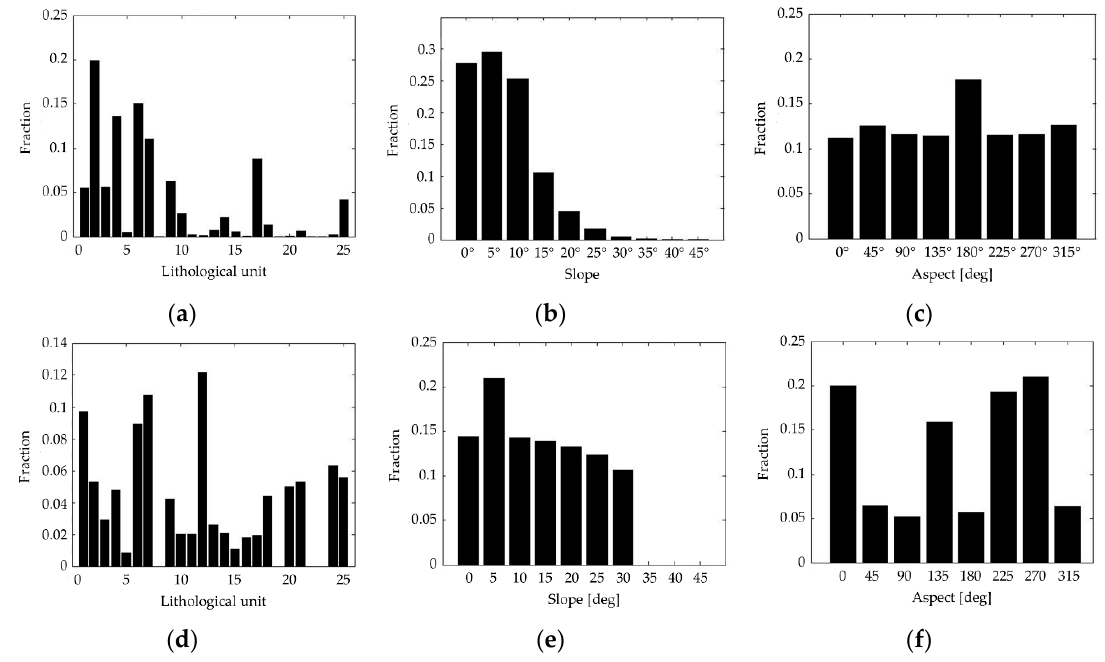
Figure 5. Normalized frequency distributions of LU units ( a ), slope ( b ) and aspect angles ( c ); normalized frequency distributions of PS (ERS 1992–1997) as a function of lithological units ( d ) slope ( e ) and aspect classes ( f ).